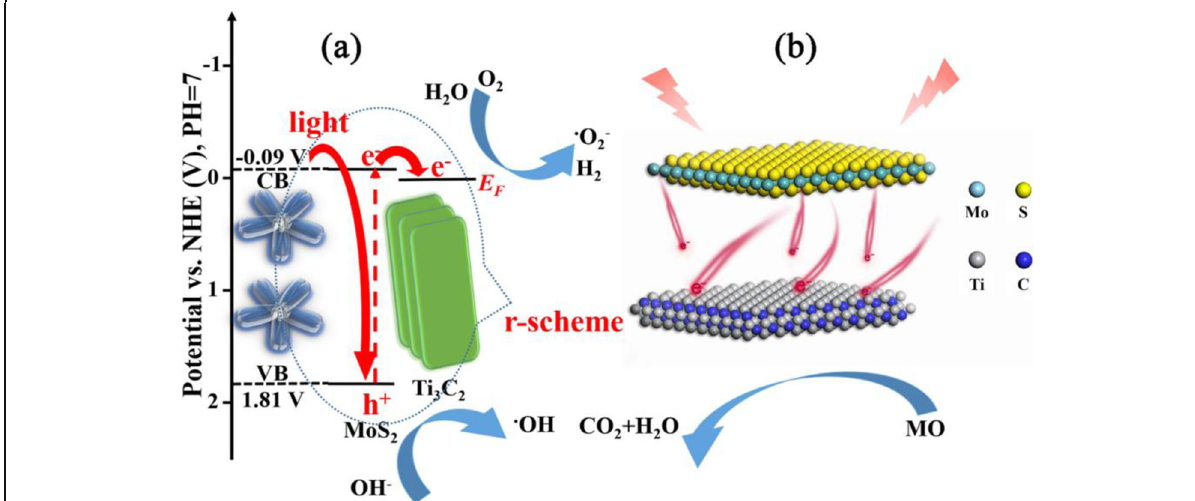
Fig. 9 a Energy level structure diagram of MoS 2 and Ti 3 C 2 . b Schematic illustration of photo-induced electron transfer process at the heterojunction